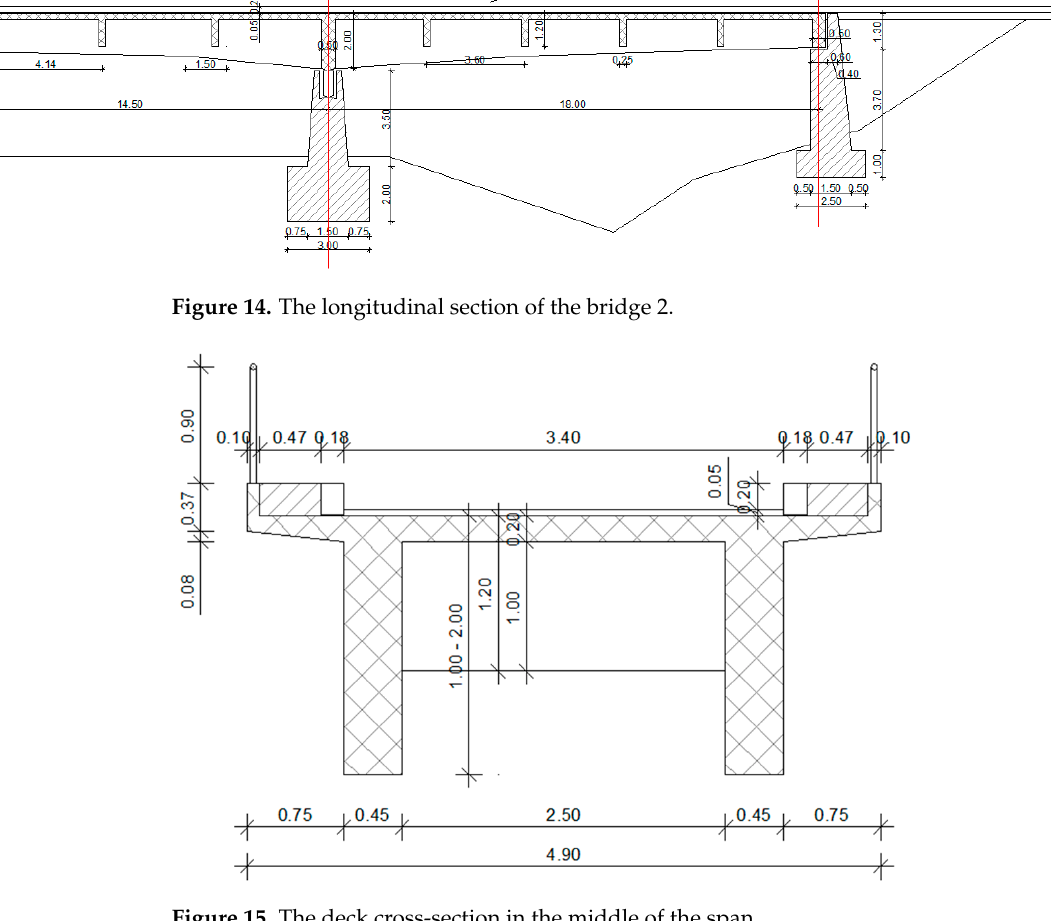
Figure 15. The deck cross-section in the middle of the span.